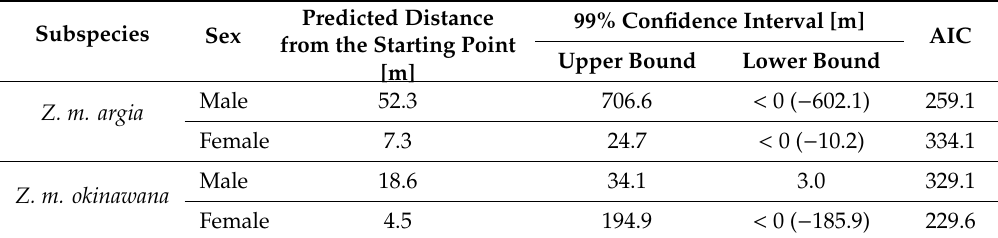
Table 4. Predicted distance from the starting point after 7200 min by the ARIMA (autoregressive integrated moving average)